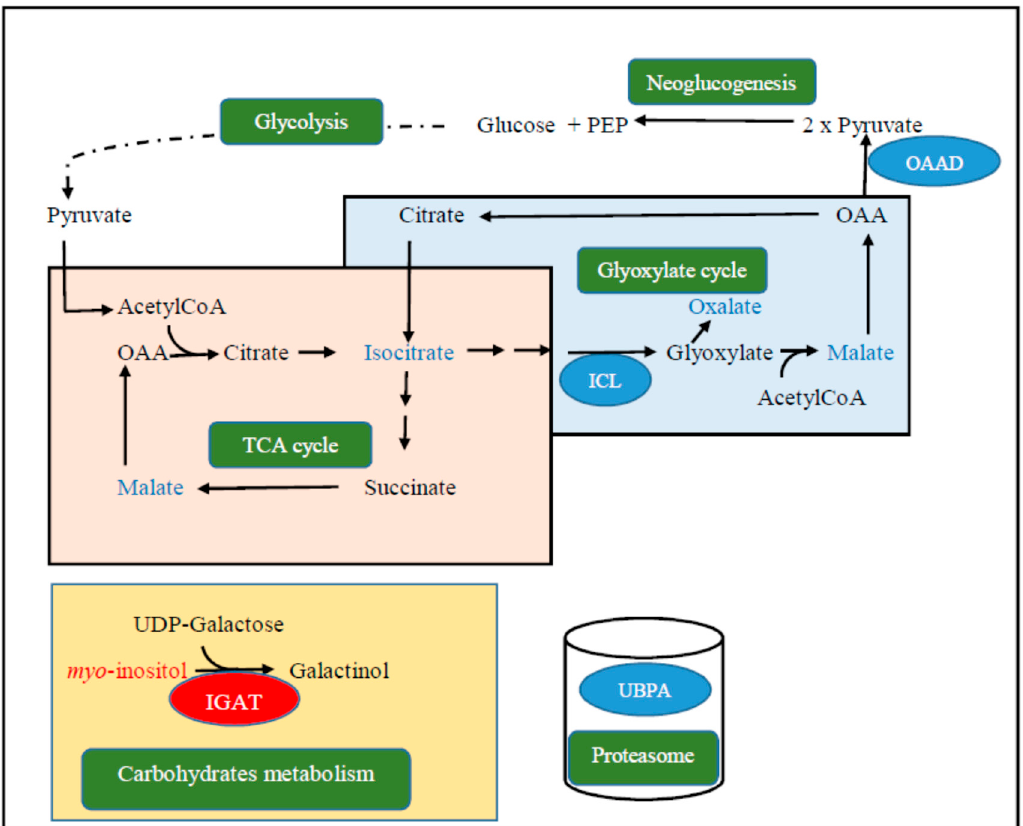
Figure 9. Hypothetical scheme of the early metabolic pathways involved in the adaptation of Quercus pubescens to drought. Complex proteins and metabolic pathways (green); proteins of upregulated transcripts (blue circle); upregulated metabolites (blue); downregulated metabolite (red); protein of downregulated transcript (red circle). Oxalocetate (OAA); oxaloacetate decarboxylase (OAAD); ubiquitin-like-protein-specific protease activity (UBPA); inositol 3- α -galactosyltransferase activity (IGAT); phosphoenolpyruvate (PEP); uridin diphosphate (UDP); tricarboxylic acid (TCA); isocitrate lyase (ICL); coenzymeA